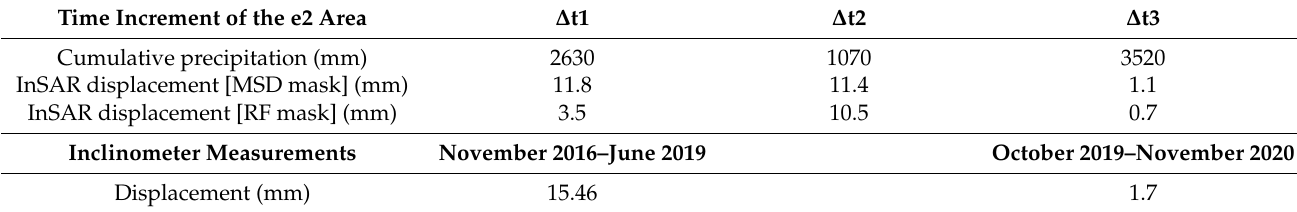
Table 3. Borehole inclinometer and InSAR time series with the time increments from the cumulative precipitation comparison, together with the results obtained by using the conventional MSD mask and RF masks for